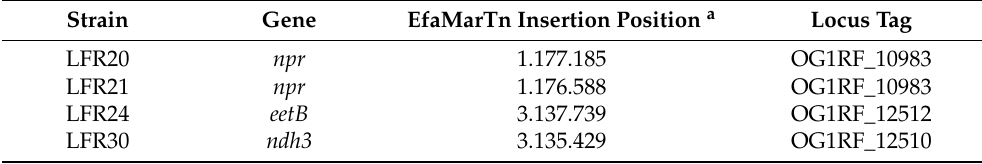
Figure 2. Map of the genes at two loci in the chromosome of E. faecalis . The transposon insertion position in the four mutants identified in this work are indicated with vertical arrows. For additional information, see Table 2. Table 2. Genotype of E. faecalis mutants identified in this work.